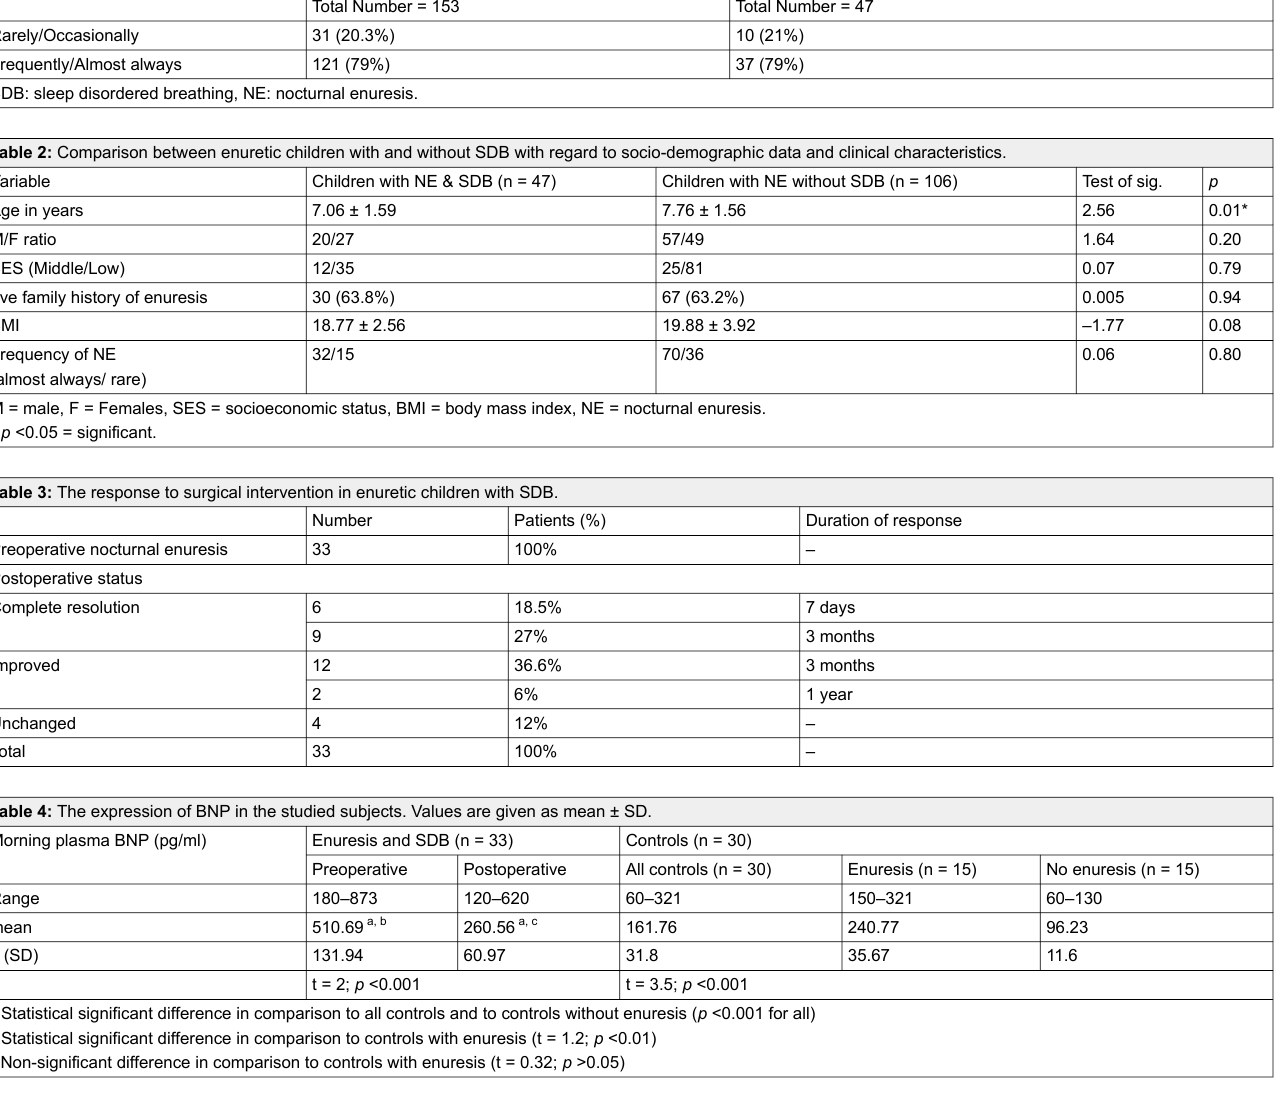
Table 1: The frequency of enuresis and sleep disordered breathing. Grading